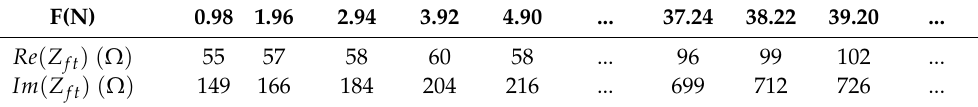
Table 6. The impedance obtained by the average of the circumcircle and the inscribed circle.